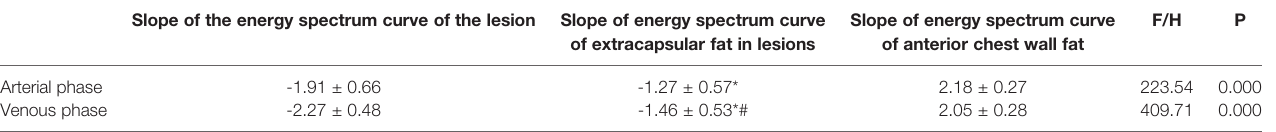
TABLE 3 | Slopes of energy spectrum curves of, extracapsular fat and anterior chest wall fat TETs stage II. Slope of the energy spectrum curve of the lesion Slope of energy spectrum curve Slope of energy spectrum curve of extracapsular fat in lesions of anterior chest wall fat